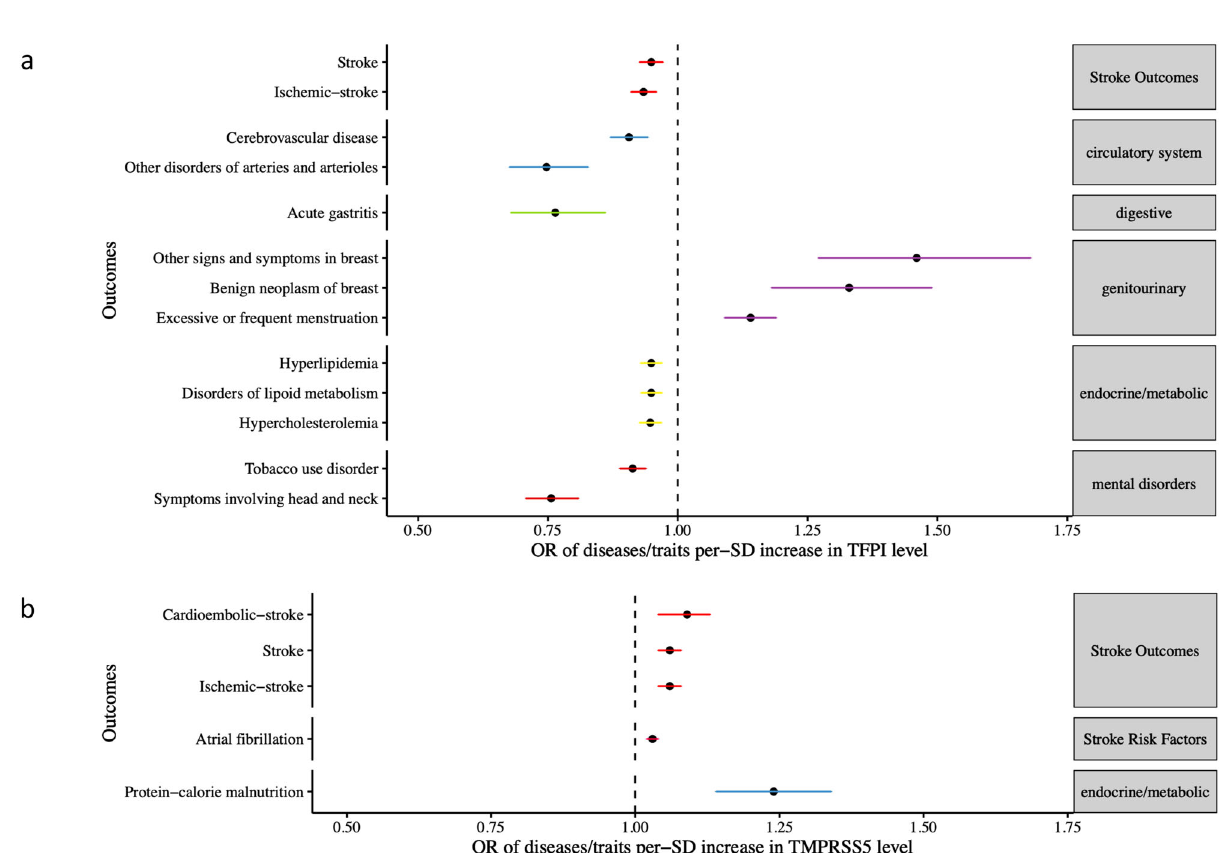
Fig. 7 | Potential on-target effects of stroke-associated proteins. Forest plots illustrating the potential on-target effects associated with causal proteins revealed by Phe-MR analysis for TFPI ( a ) and TMPRSS5 ( b ). In general, results can be per- ceivedastheeffectsofper-SDhighercirculatingproteinleveloneachphenotype.If theeffectdirectionofthetargetproteinonthephenotypeisconsistentwiththaton stroke outcomes, it represents 'bene fi cial' additional indications through the intervention of circulating protein level. Conversely, opposing effect directions of the target protein on the phenotype and stroke represents 'deleterious' side-